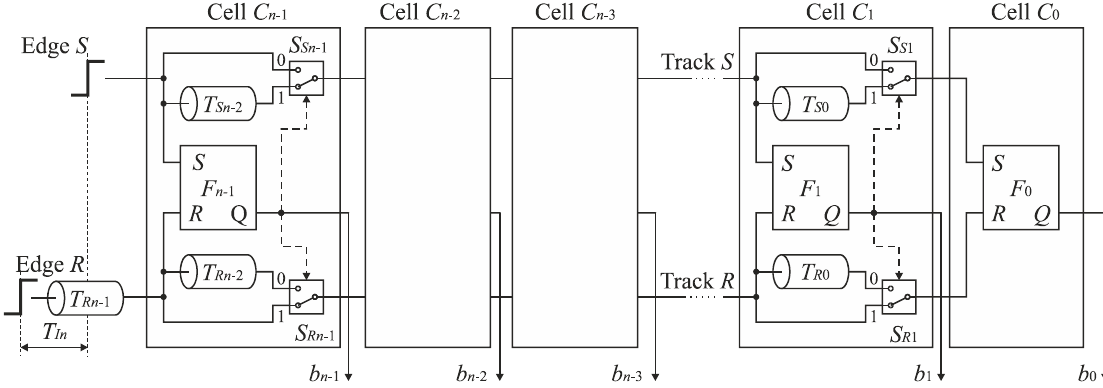
Figure 14. Basic n -bit feedforward SA-TDC architecture for unipolar input time interval T In .